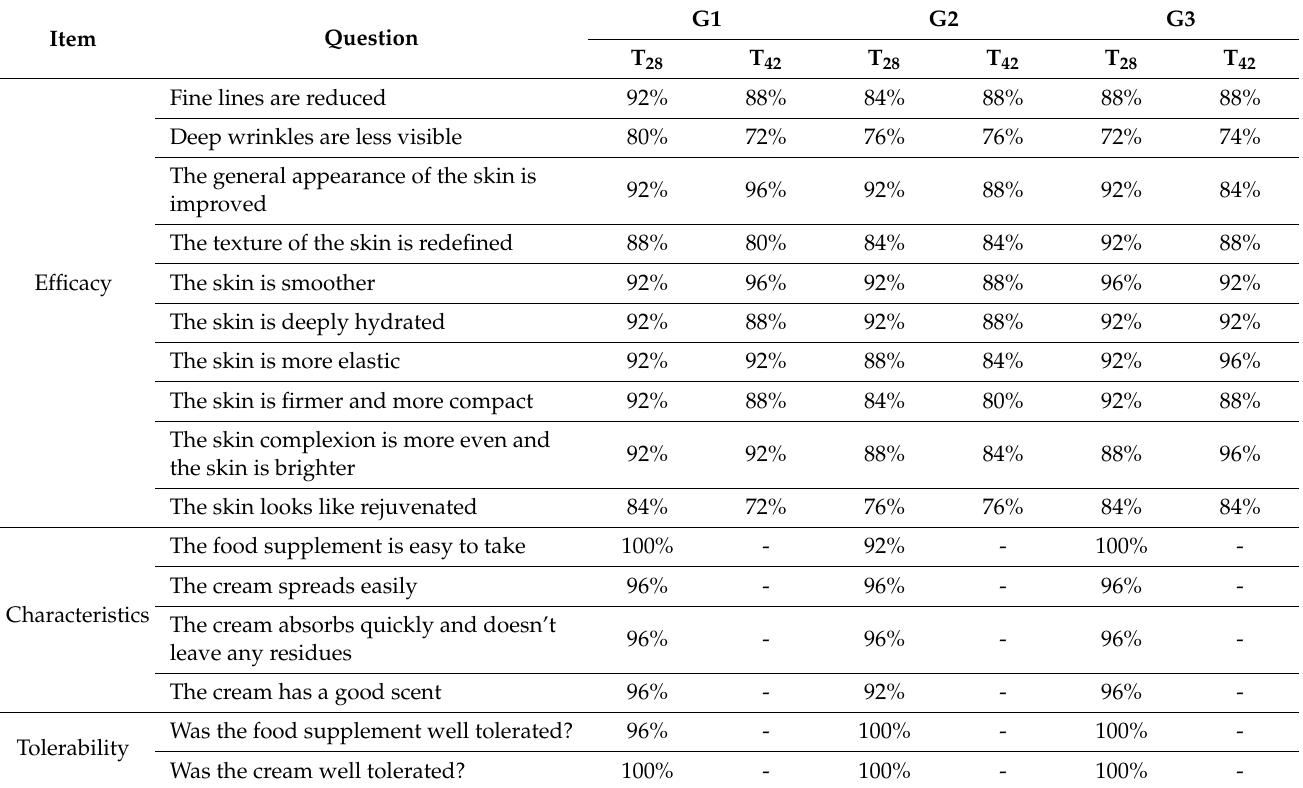
Table 1. Self-assessment questionnaire. Data are expressed as percentage of positive answers collected at the end of the treatment period (T 28 ) and after the follow-up period (T 42 ). At T 42 , questions about characteristics and tolerability were not asked